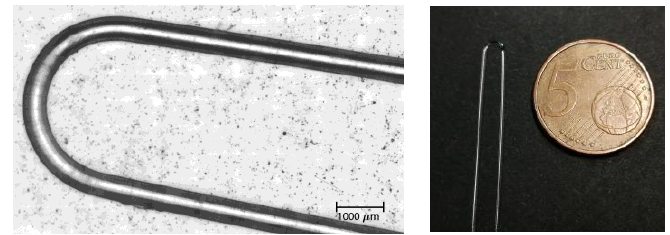
Figure 4. Pictures of the sensor-probe: microscopic picture ( left ) and a comparison with a 5 cent Euro coin ( right ).